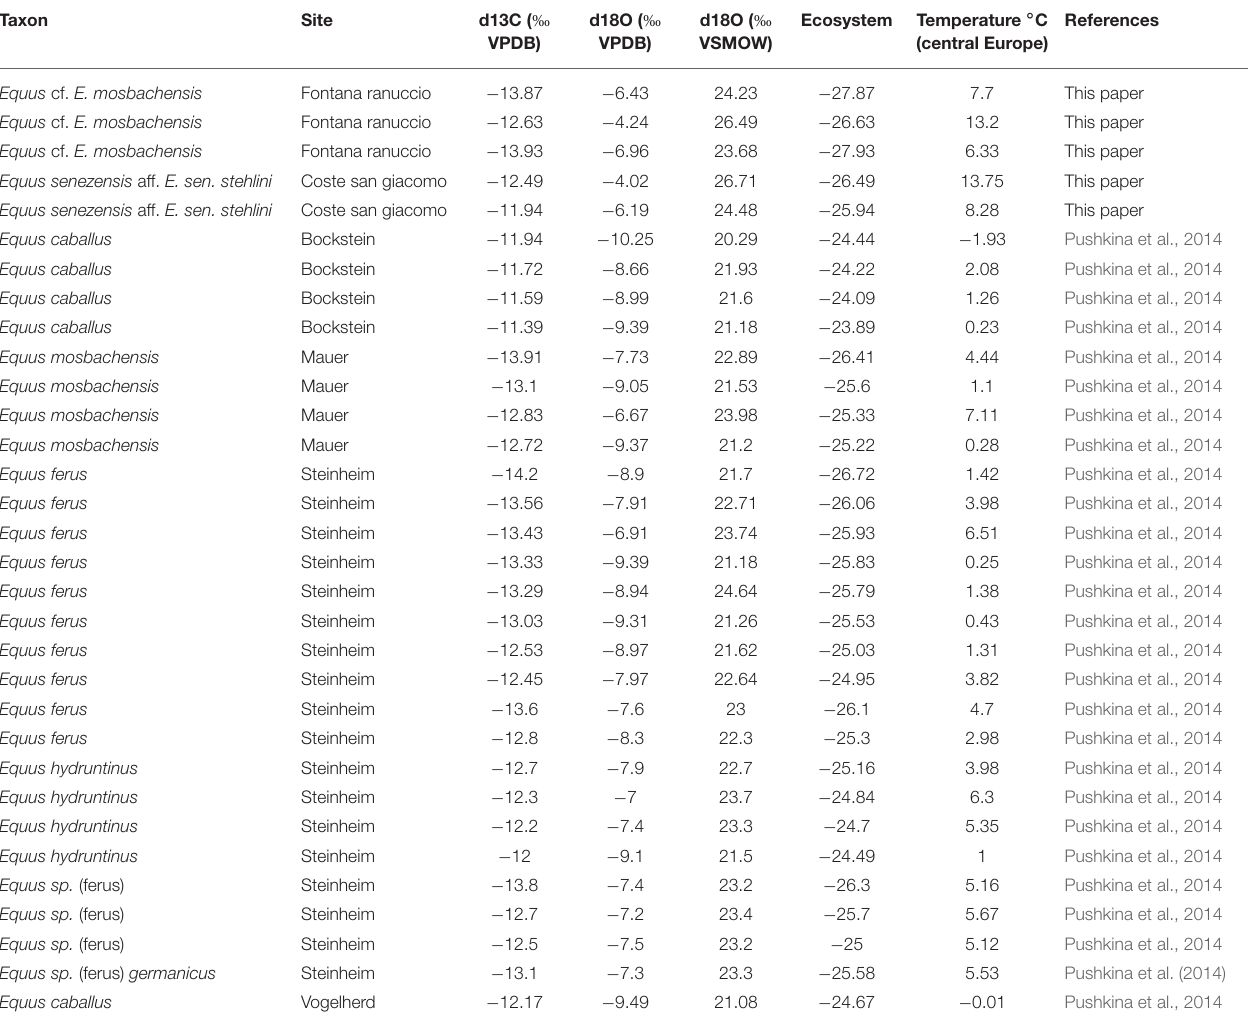
TABLE 2 | Isotopic results for Equus senezensis aff. E. sen. stehlini from CSG, Equus cf. E. mosbachensis from FR, and for Pleistocene equids from German localities [data from Pushkina et al.